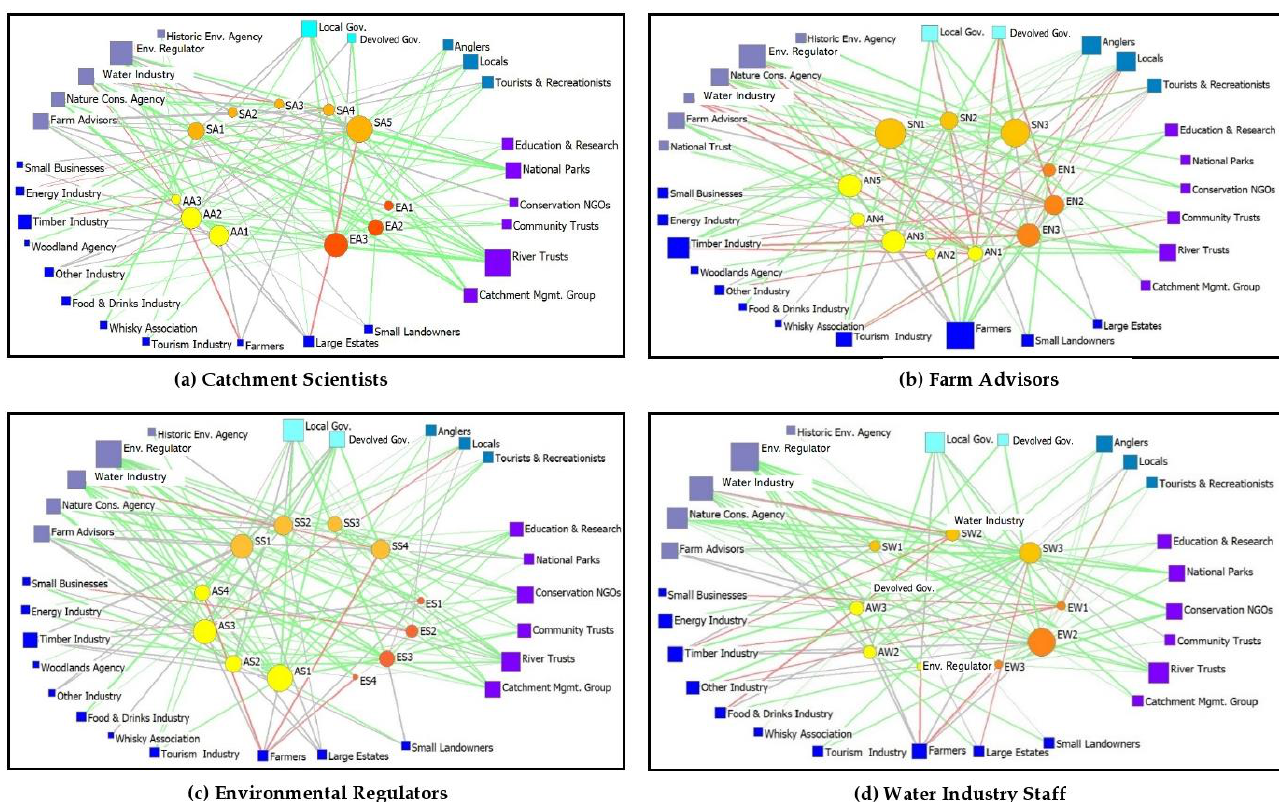
Figure 8. Two-mode networks from the ( a ) Catchment Scientist, ( b ) Farm Advisor, ( c ) Environmental Regulator and ( d ) Water Industry Staff stakeholders. Depicting responses of stakeholder typologies (squares, coloured to distinguish government (turquoise), public bodies (grey), private business (blue), other stakeholders (purple) and individual actors (cyan)) by individual participants (circles, yellow (Catchment Scientists; i.e., EA1–3), amber (Environmental Regulators; i.e., ES1–4), light orange (Farm Advisors; i.e., EN1–3) and dark orange (Water Industry staff; i.e., EW1–3)) with tie strength depicting a small, medium or large influence on the catchment and tie colour showing a negative (red), neutral (grey) or positive influence (green). Node size depicts degree score.